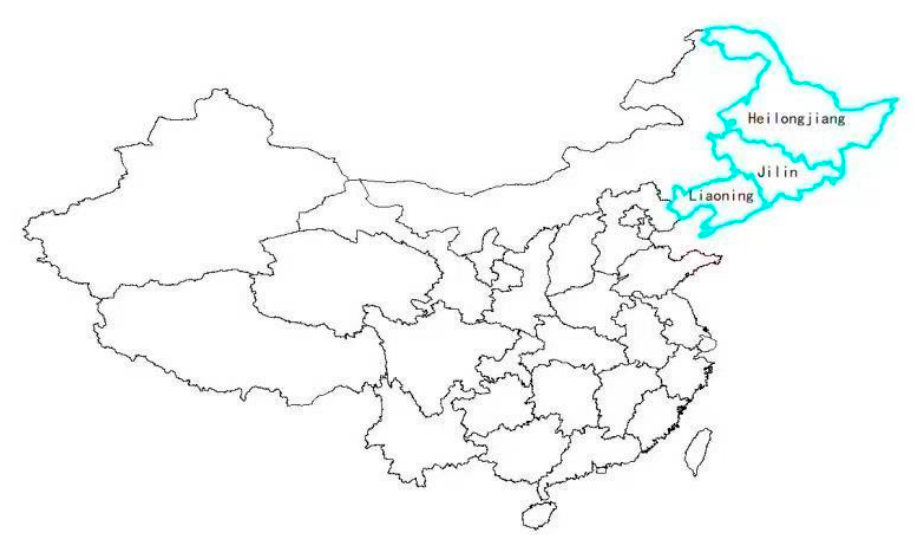
Figure 1. The location of the northeast region in China.